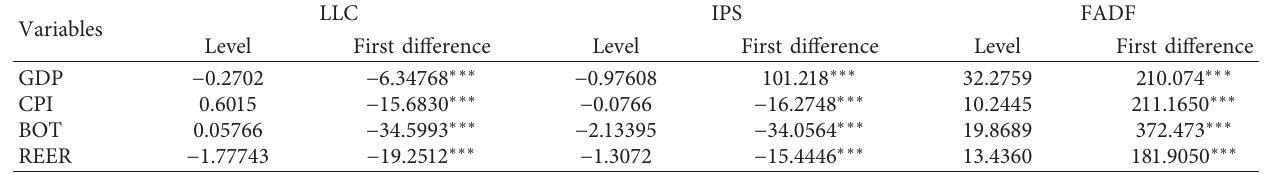
Table 2: The results of panel unit root tests.